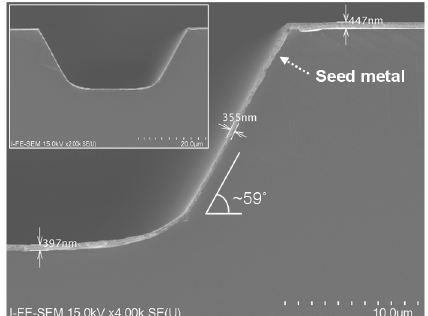
Figure 10. SEM images of an InP via hole with a gradual sidewall slope of 59 degrees where seed metals were deposited.